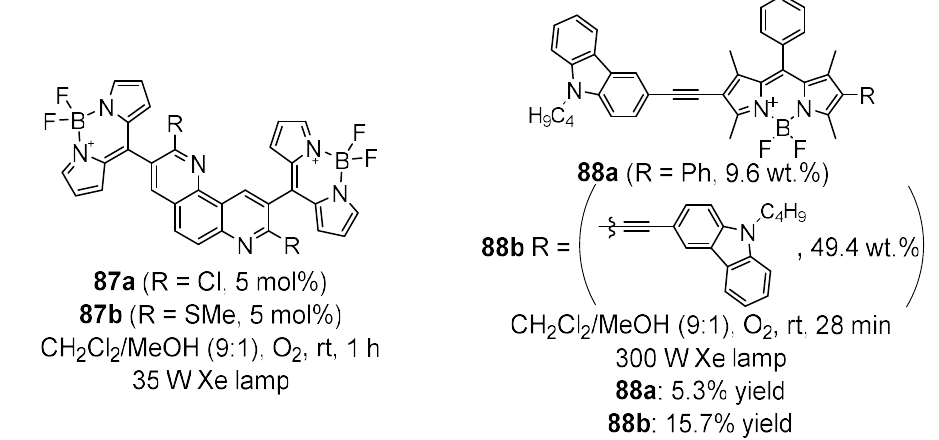
Figure 24. Results obtained in the aerobic oxidative dehydrogenation of 1,5-dihydroxynaphthalene to Juglone ( 85 : R 1 = R 2 = R 5 = H, R 4 = OH) catalyzed by 87 and 88 . to Juglone ( 85 : R 1 = R 2 = R 5 = H, R 4 = OH) catalyzed by 87 and 88